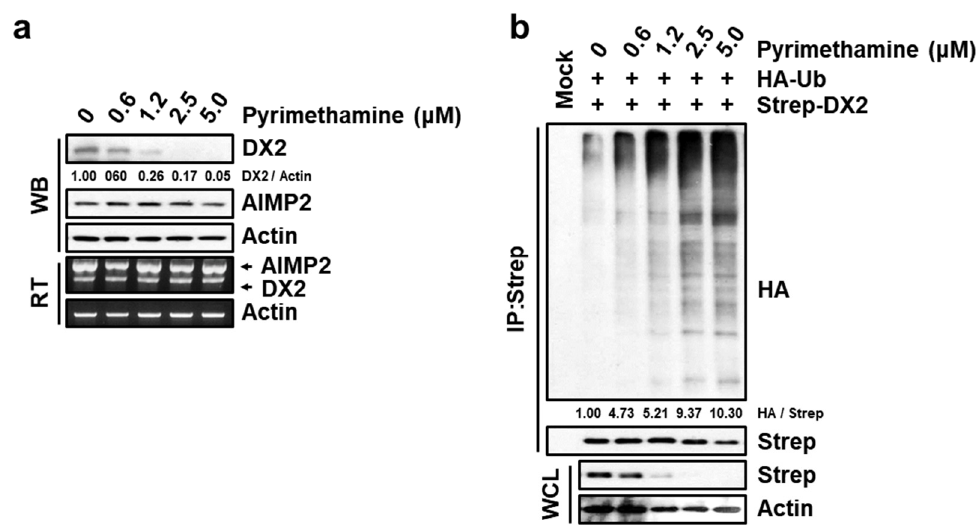
Figure 4. Specific inhibitory e ff ect of pyrimethamine on DX2 protein expression. ( a ), Pyrimethamine- dependent level of DX2 protein and mRNA. Pyrimethamine-treated (12 h) H460 cells were subjected to Western blotting (WB) and Reverse transcriptase polymerase chain reaction (RT-PCR) for detecting the indicated proteins and mRNAs, respectively. Actin was used as the loading control. ( b ), Pyrimethamine-mediated ubiquitination of DX2. 293T cells expressing Strep-DX2 and HA-ubiquitin (Ub) were treated with pyrimethamine and MG-132 for 12 h. HA attached the ubiquitin as a tag is the abbreviated name from hemagglutinin. IP and WCL means immunoprecipitation and whole cell lysates, respectively. ( a , b ), The numbers below the image panel mean the quantified value.